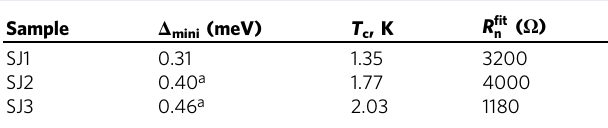
Table 4 Fitting parameters for SJ1. Method